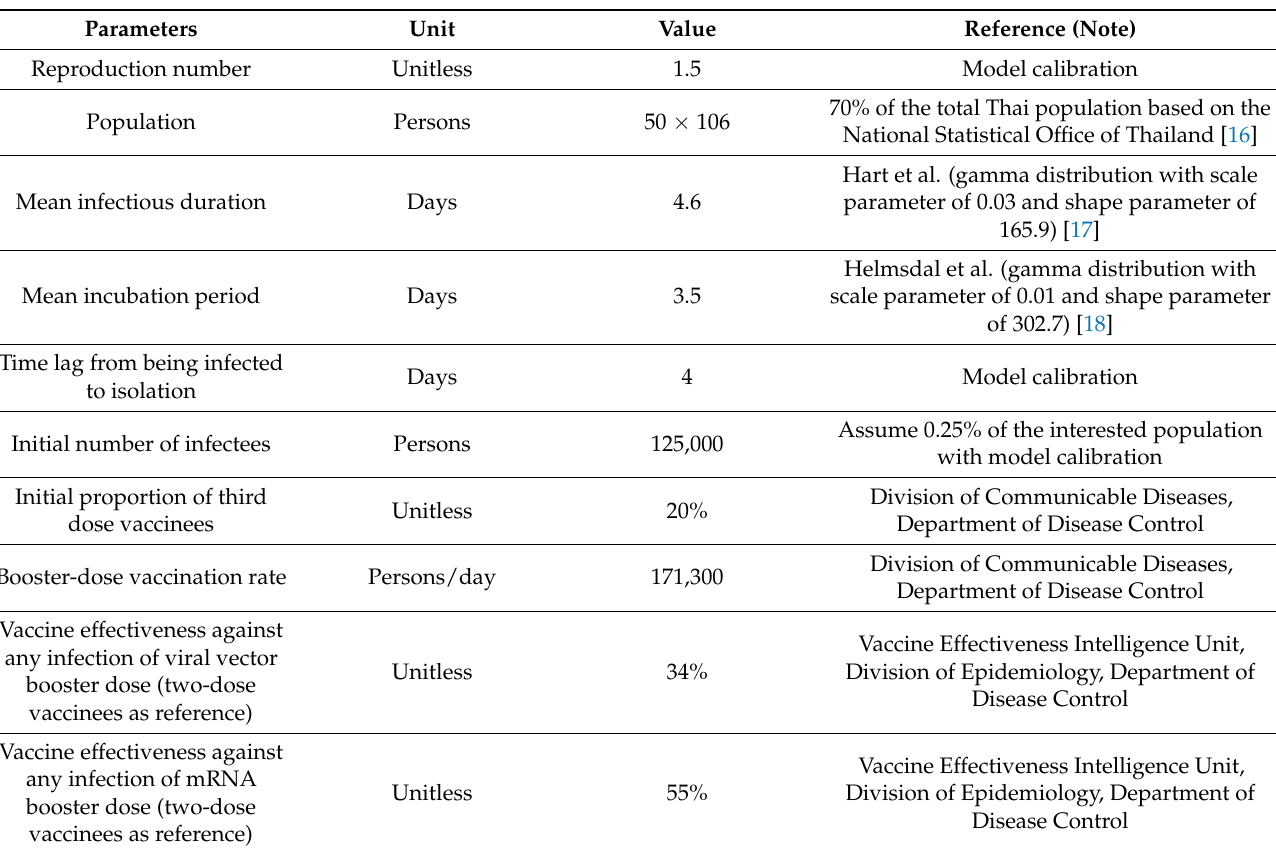
Table 2. List of key